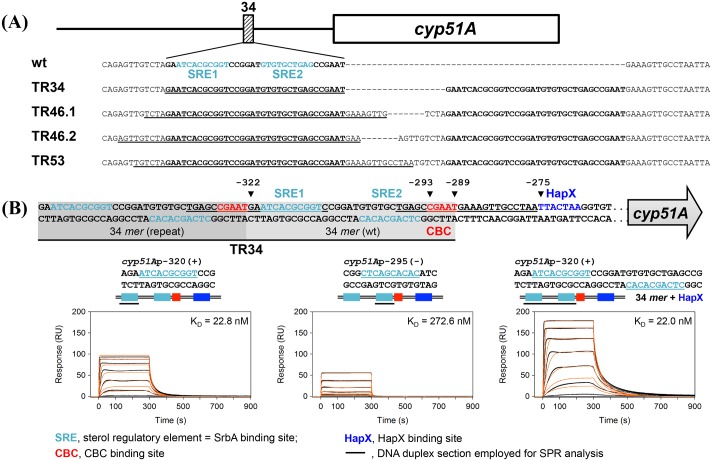
SrbA interacts with a transcriptional enhancer within the 34 mer.(A) Alignment of TR34, TR46.1, TR46.2 and TR53. The 34 mer is duplicated in all TR variants (adapted from [30]). bold, 34 mer; underlined, duplicated sequence. (B) To further analyze the in vivo binding data described by Chung et al. [27], we measured binding of recombinant SrbA to this section using real-time SPR analysis. The putative binding sites identified by comparison to the consensus sequence are shown as SRE1 and SRE2. DNA duplexes containing either SRE1, SRE2 or both were used for SPR analysis. Sensorgrams of 200, 100, 50, 25, 12.5, 6.25, and 3.13 nM SrbA161-267 binding injected in duplicate (black lines) are shown overlaid with the best fit derived from a 1:1 interaction model including a mass transport term (red lines).